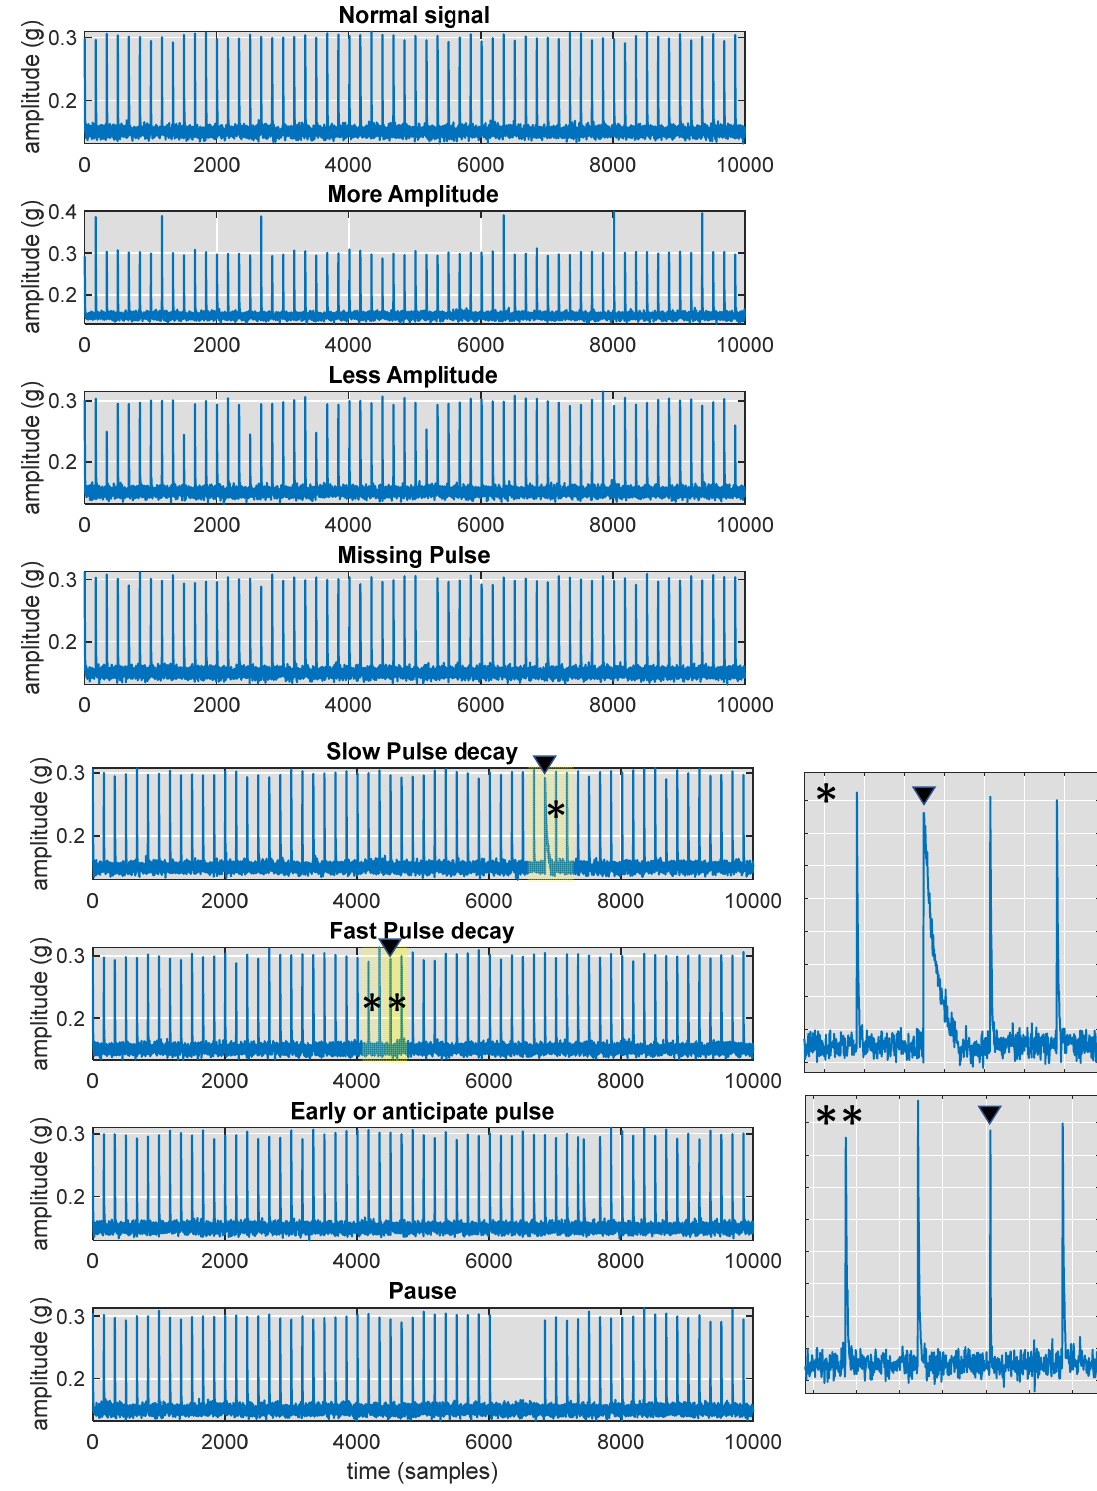
Figure 2. Synthetic signals representing each anomaly at a stimulation frequency of 6 Hz. The asterisk (*) indicates a zoom into figure. The triangle indicates the anomaly location.